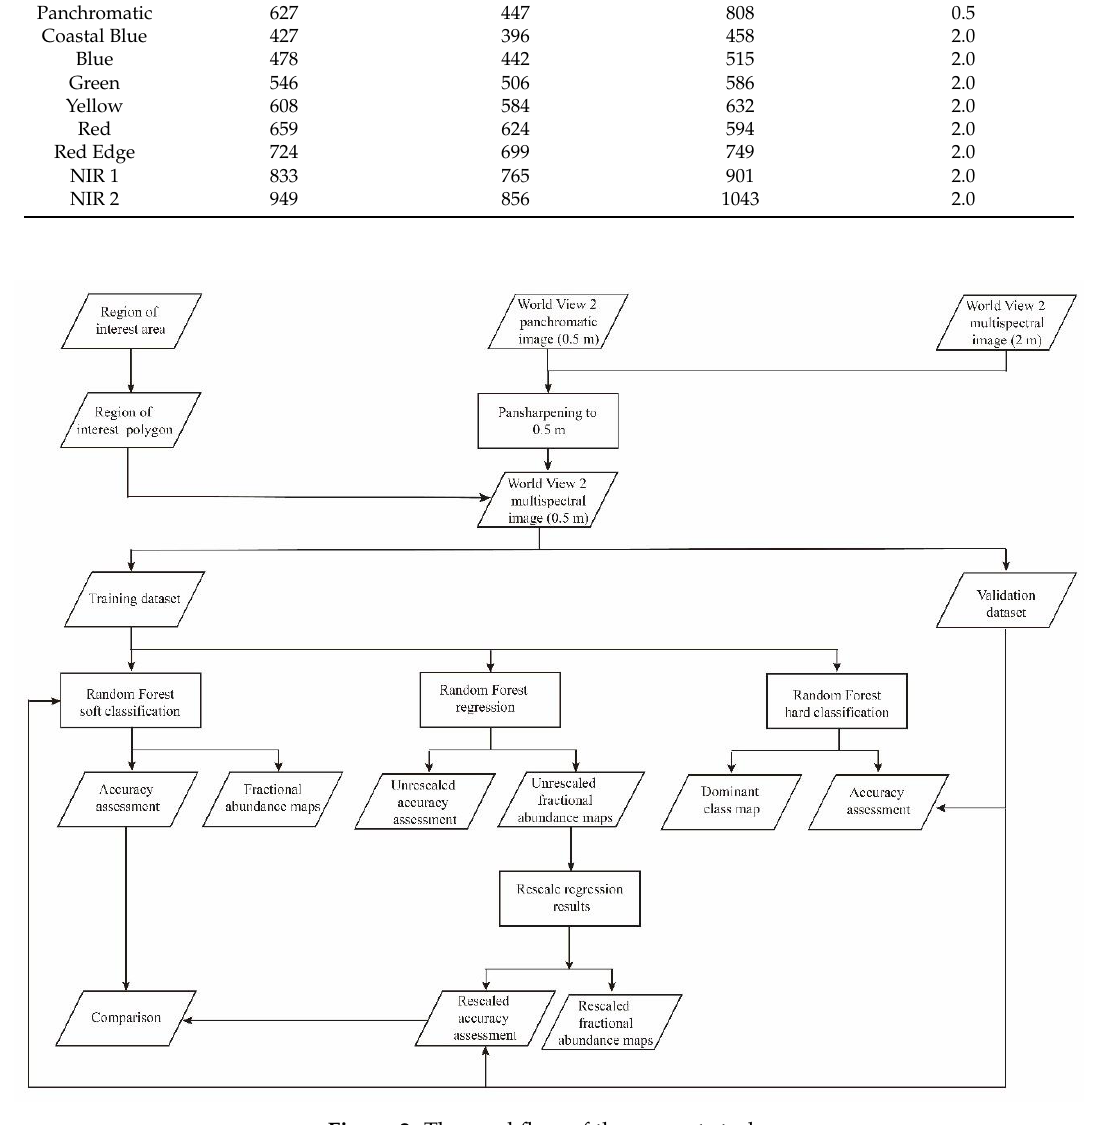
Figure 2. The workflow of the present study.